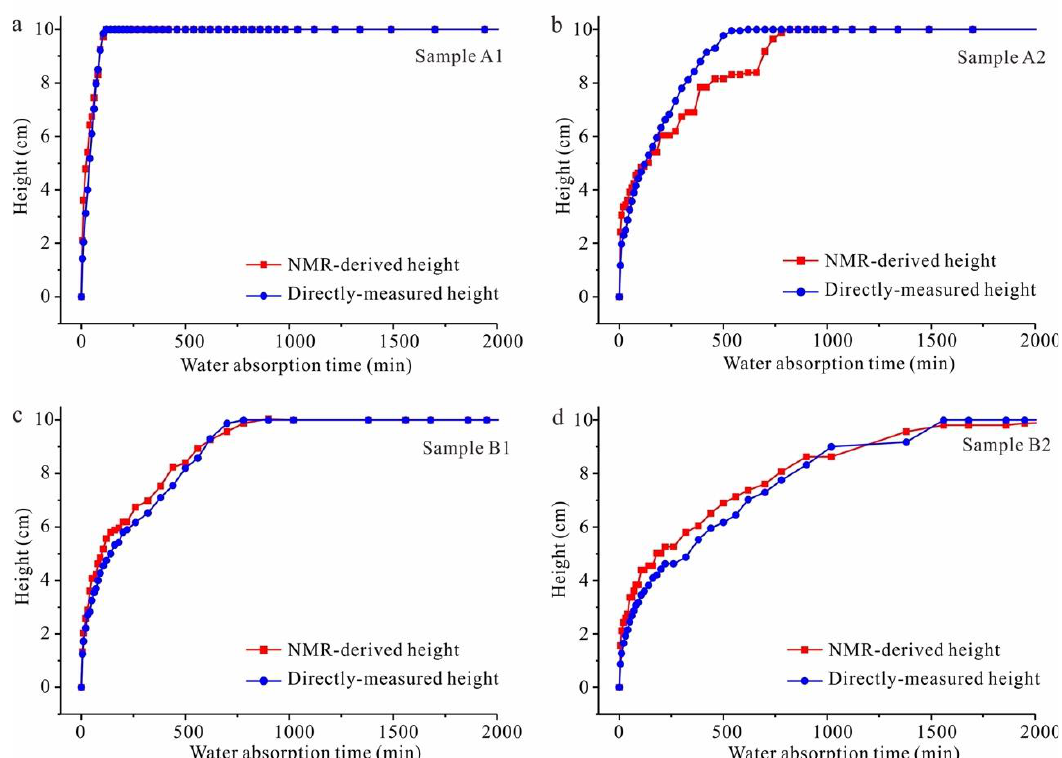
Figure 8. Comparison of NMR-derived and directly measured water-absorption front heights during the saturation process in ( a ) Sample A1; ( b ) Sample A2; ( c ) Sample B1 and ( d ) Sample B2.